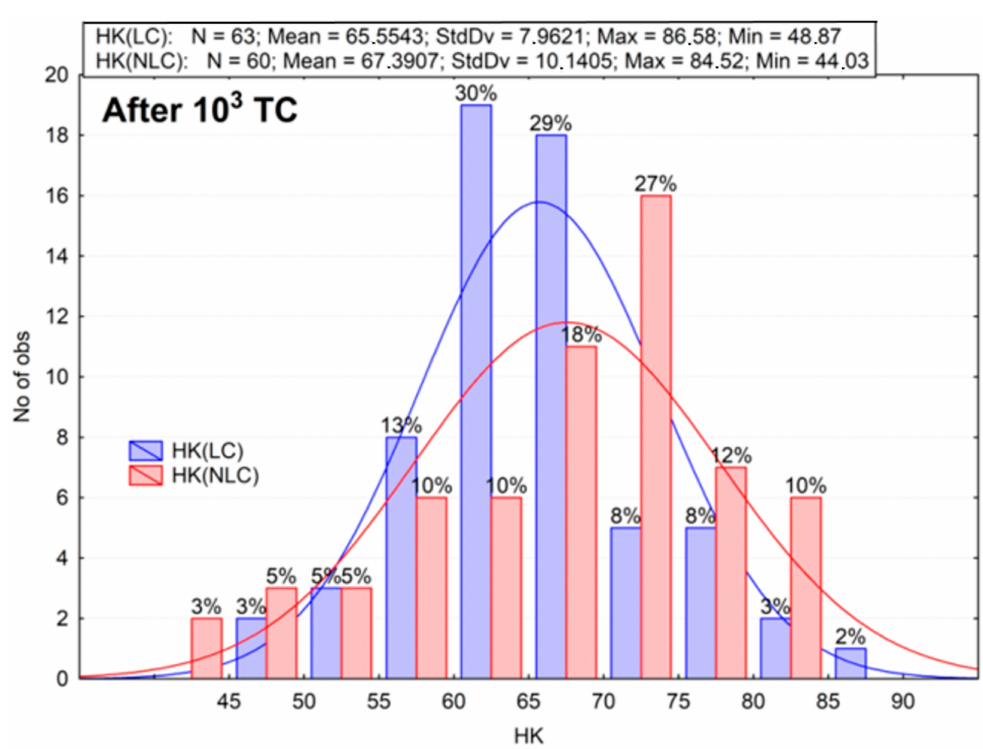
Figure 5. The results of Knoop hardness measurements for Z550 after thermocycling (TC). LC—light- cured surface of sample (top side of sample), NLC—non-light-cured surface (bottom side of sample), HK—Knoop hardness.